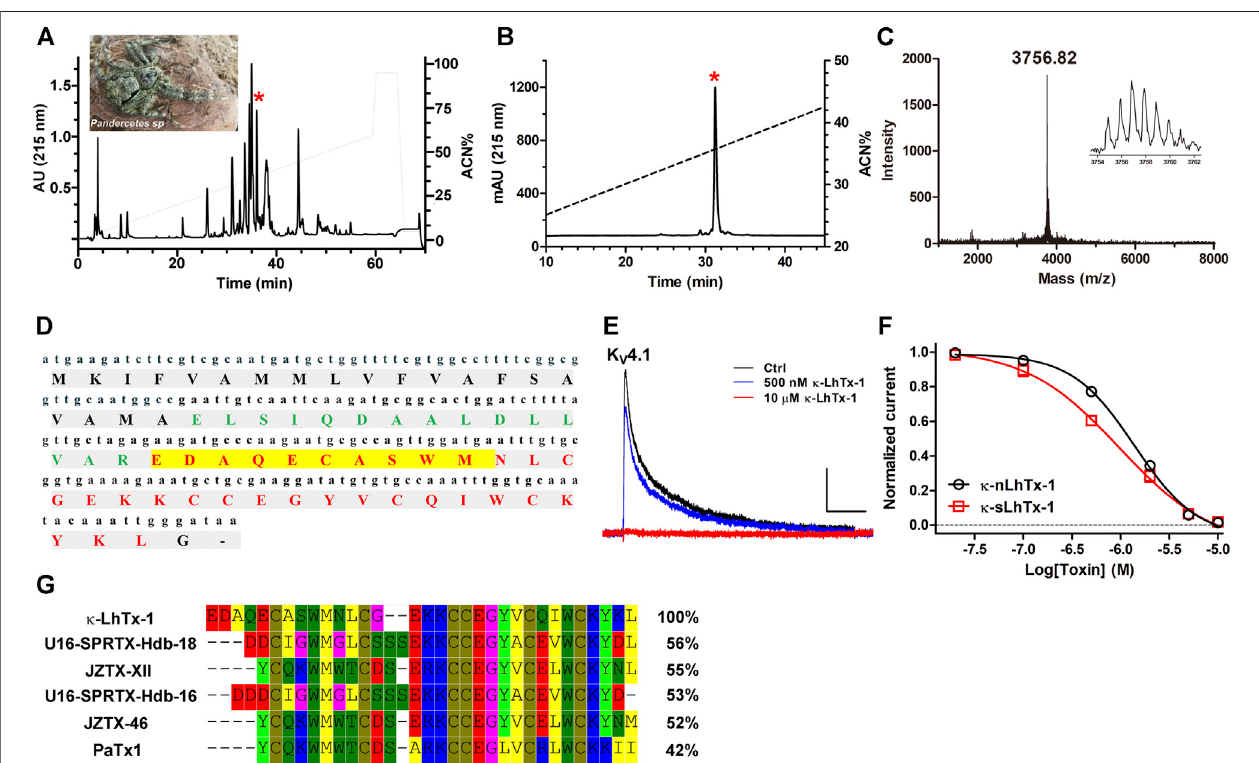
FIGURE 1 | Puri fi cation and characterization of κ -LhTx-1. (A) , RP-HPLC pro fi le of Pandercetes sp (inset) venom , the red asterisk labeled peak contains κ -LhTx-1. (B) , κ -LhTx-1waspuri fi edtohomogeneitybyanalyticalRP-HPLC(redasterisklabeledpeak). (C) ,MALDI-TOFMSanalysisofpuri fi ed κ -LhTx-1,theinsetshowsitssingle isotopic molecular weight. (D) , cDNA and protein sequence of κ -LhTx-1. The signal peptide, propeptide and mature peptide was shown in black bold, green bold and red bold, respectively. N-terminal sequence of κ -LhTx-1 was determined by Edman degradation and highlighted in yellow. (E) , Representative traces showing K V 4.1 was concentration-dependently inhibited by κ -nLhTx-1 (n (cid:2) 5). Currents were elicited by a 300 ms depolarization to +30 mV from − 80 mV holding. Scale bars, 0.5 nA × 50 ms. (F) , The concentration-response curves of κ -nLhTx-1 and κ -sLhTx-1 inhibiting K V 4.1 at + 30 mV, the IC 50 values were determined as 1.36 ± 0.38 μ M and 0.87 ± 0.15 μ M for κ -nLhTx-1 and κ -sLhTx-1, respectively (n (cid:2) 5). (G) , Sequence alignment of κ -LhTx-1 with several toxins in the database using